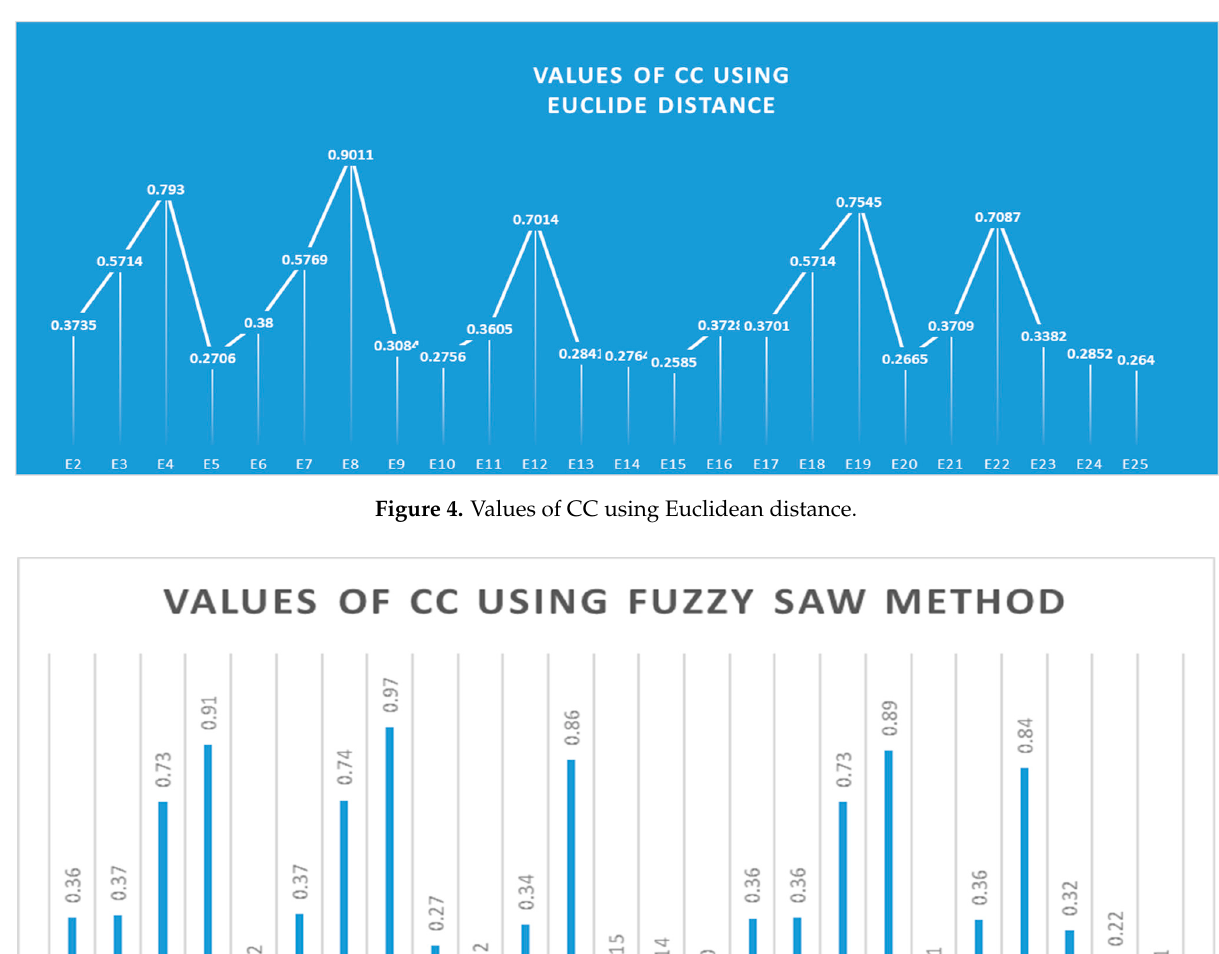
Figure 3. Values of CC using Hamming distance.